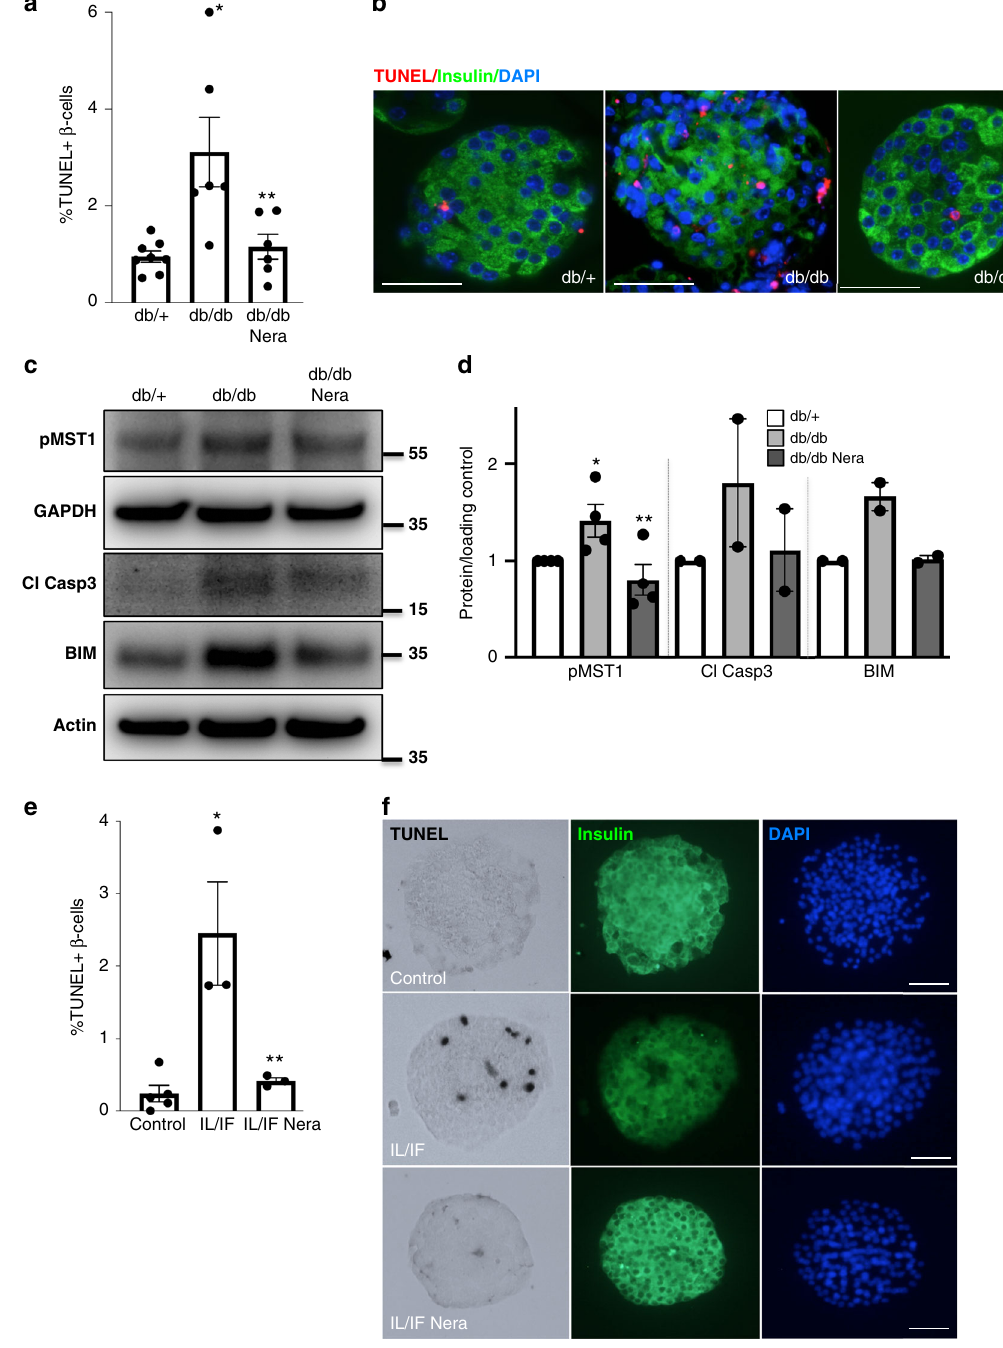
Fig. 9 Neratinib improves β -cell survival in islets in a therapeutic ex vivo approach. a , b Isolated islets from 10-week-old obese diabetic Lepr db/db mice or their heterozygous db/ + littermates were exposed to 10 μ M neratinib for 24 h, fi xed, and 2- μ m sections were prepared. a Percentage of TUNEL-positive β - cells is shown as means ± SEM. b β -cell apoptosis was analyzed from islet sections by triple staining of TUNEL (red nuclei), insulin (green), and dapi